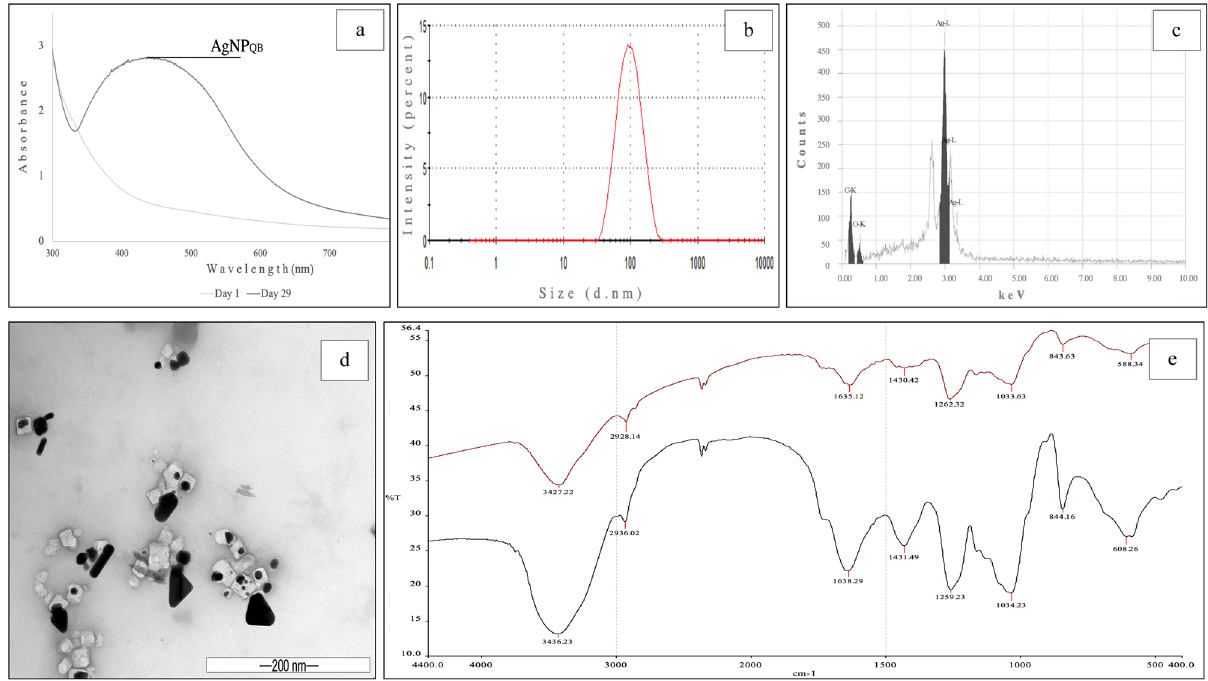
Figure 3: Characterization of biosynthesized AgNP QB using: ( a ) UV - vis spectroscopy, ( b ) DLS, ( c ) EDS of AgNP QB presenting 70% of Ag, ( d ) TEM imaging, and ( e ) FTIR of H. clathratus raw powder aqueous solution before ( black ) and after AgNP